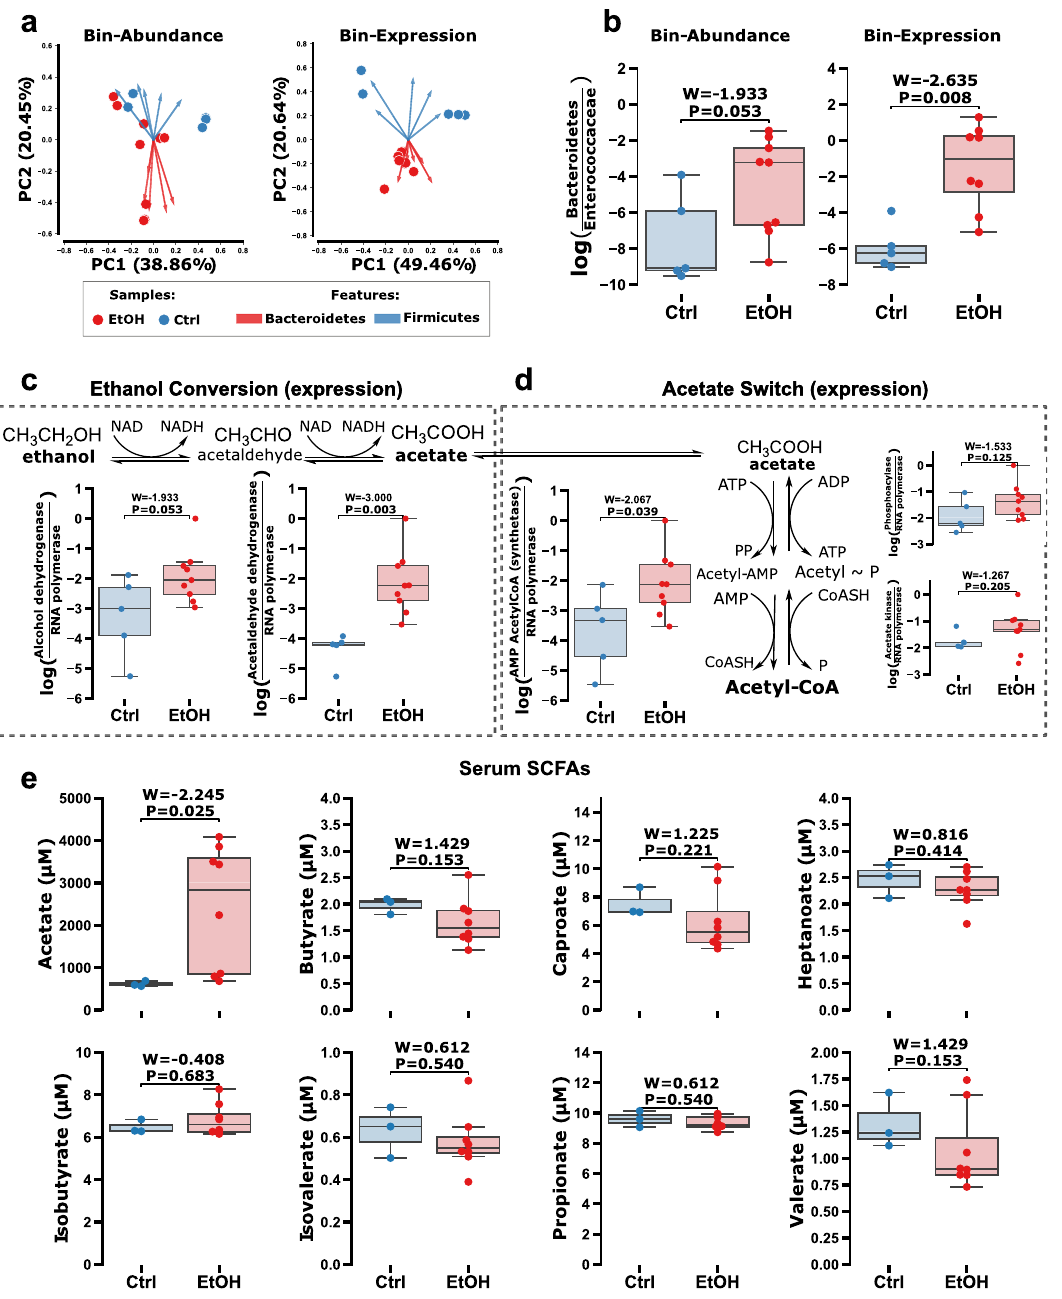
Fig. 2 Acetate scavenging and Bacteroides strains are upregulated while alcohol dehydrogenation is not changed in alcohol (red) fed mice compared to controls (blue). a Compositional biplot of Aitchison distances on bin abundance (left) and expression (right) between conditions with arrows colored by Phylum level taxonomy. b The log-ratio of Bacteroidetes and Enterococcaceae strains (y-axes) identi fi ed in biplot for bin abundance (left) and expression (right) compared between treatment groups (x-axes). c Microbial alcohol dehydrogenase (left) and acetaldehyde dehydrogenase (right) log-ratios compared between treatments (x-axes). d Conversion in acetate switch for dissimilation (left) or excretion (right) log-ratios (y-axes) compared between treatments (x-axes). Serum short-chain fatty acids (SCFAs) (y-axis) after ethanol-feeding (x-axes) for ( e ) acetate, ( e top left) butyrate, ( e bottom left) propionate, ( e top right) isovalerate, and ( e bottom right) valerate. Box plots represent the minimum, maximum, median, fi rst, and third quartile values (shaded region). Signi fi cance was evaluated by a two-sided Wilcoxon rank sum test with Tukey ’ s HSD post-hoc test adjusted p values of less than 0.05 were shown in the fi gure ( N = 14). Source data are provided as a Source Data fi